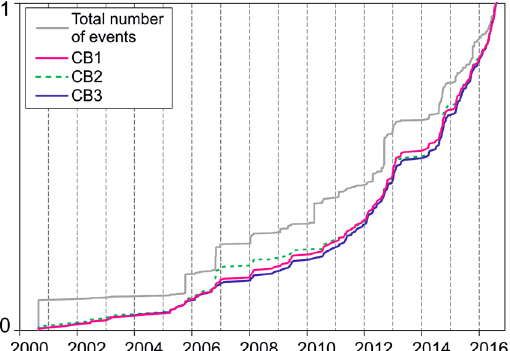
Figure 3. Cumulative curves of total events (magnitude > − 0.5) and of de-clustered events (CB1, CB2 and